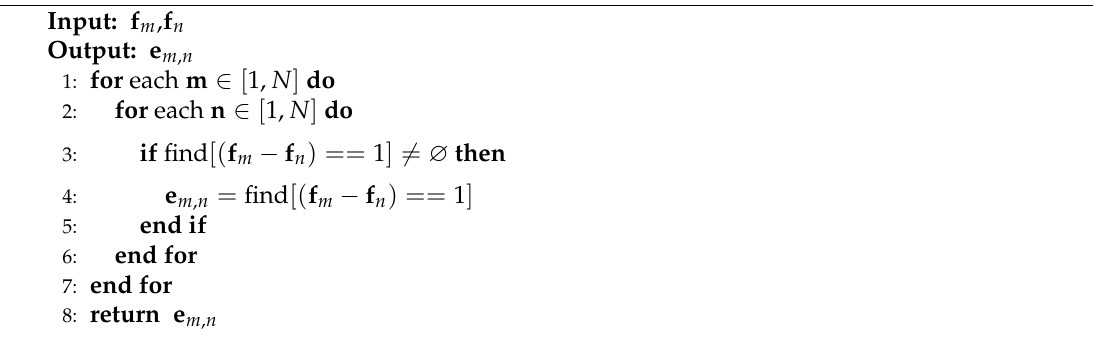
Algorithm 1: Calculating the pairwise diagnostic